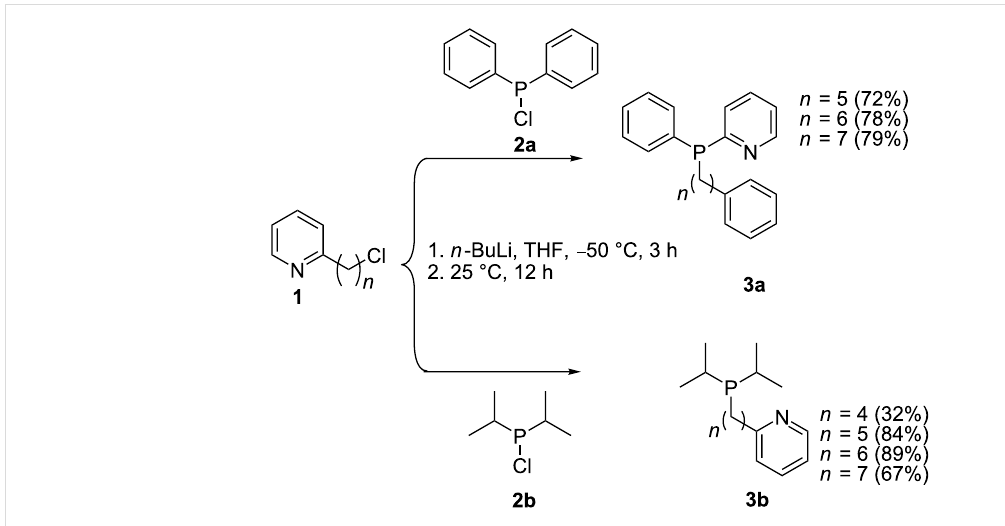
Scheme 1: Synthesis of pyridylphosphine ligands.